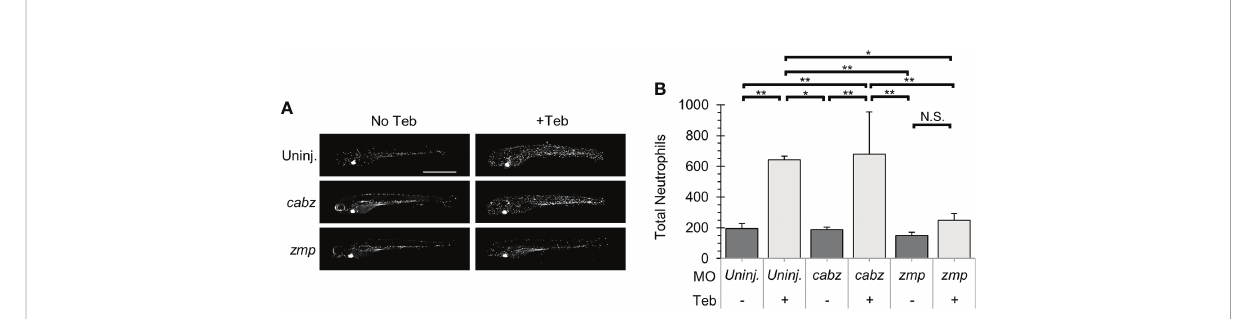
FIGURE 6 Il-1 b -induced neutrophil recruitment. (A) Representative confocal images of ubb:Gal4-EcR , uas:Il b mat , mpx:mCherry larvae. Shown here are uninjected larvae, cabz morphants, and zmp morphants without Teb (No Teb) and with Teb treatment (+Teb). (B) Neutrophils were counted using FIJI Cell Counter and Total Neutrophil counts were plotted for each group. Error Bars are +1 standard deviation. Asterisks indicate signi fi cant differences *p < 0.05 **p < 0.01; N.S., not signi fi cant; by one-way ANOVA followed by Tukey ’ s HSD Test. Scale bar in (A) is 1 mm.